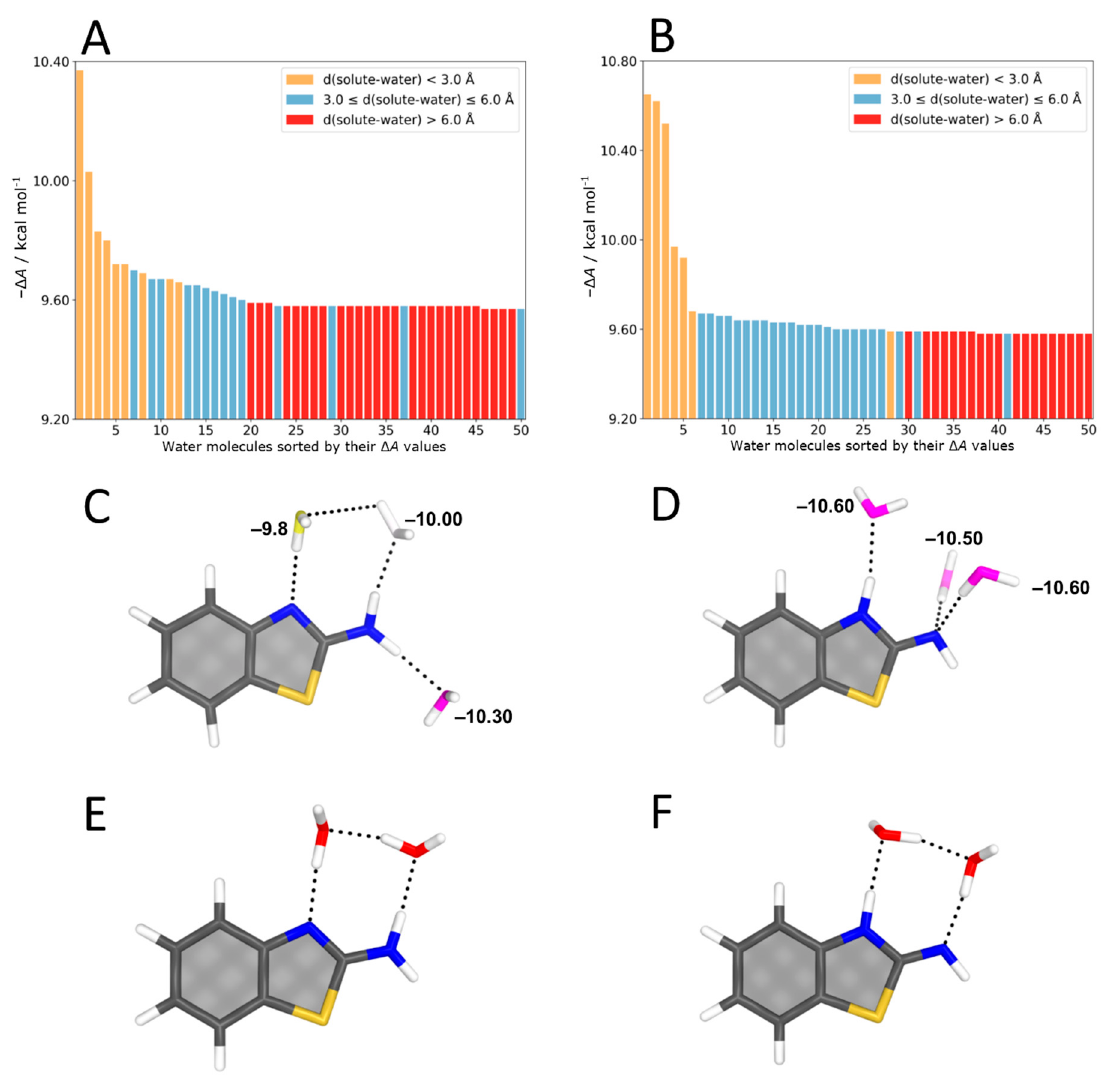
Figure 7. Ranking of the automatically placed water molecules around the T1 ( A ) and the T2 ( B ) conformer of 2- aminobenzothiazole. Representation of T1 ( C ) and T2 ( D ) water clusters with three explicit water molecules; water molecules are color-coded according to their free energy from pink (very favorable) to yellow (less favorable); B3LYP/def2- TZVP/D3 optimized conformers of T1-(H 2 O) 2 ( E ) and T2-(H 2 O) 2 ( F ).